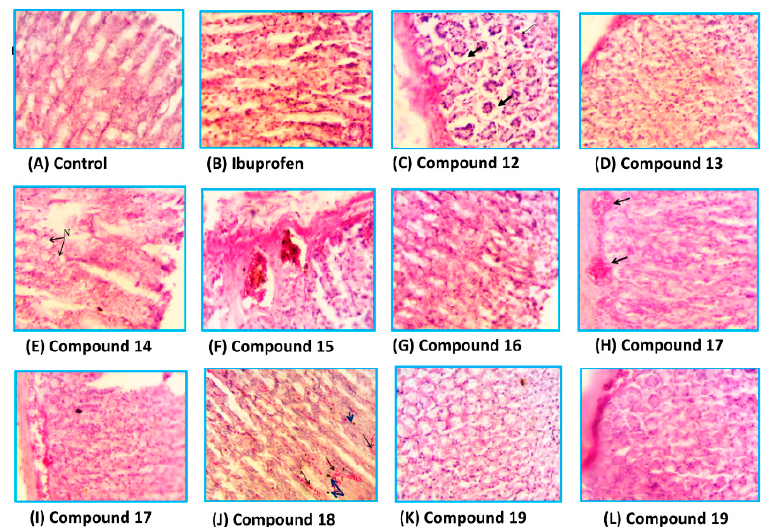
Figure 7. The histological TSs ( C – L ) in the stomach of rat treated with compounds 12 – 19 , respectively in comparison to control ( A ) and ibuprofen ( B ), using haematoxylin and eosin stain, 400×.